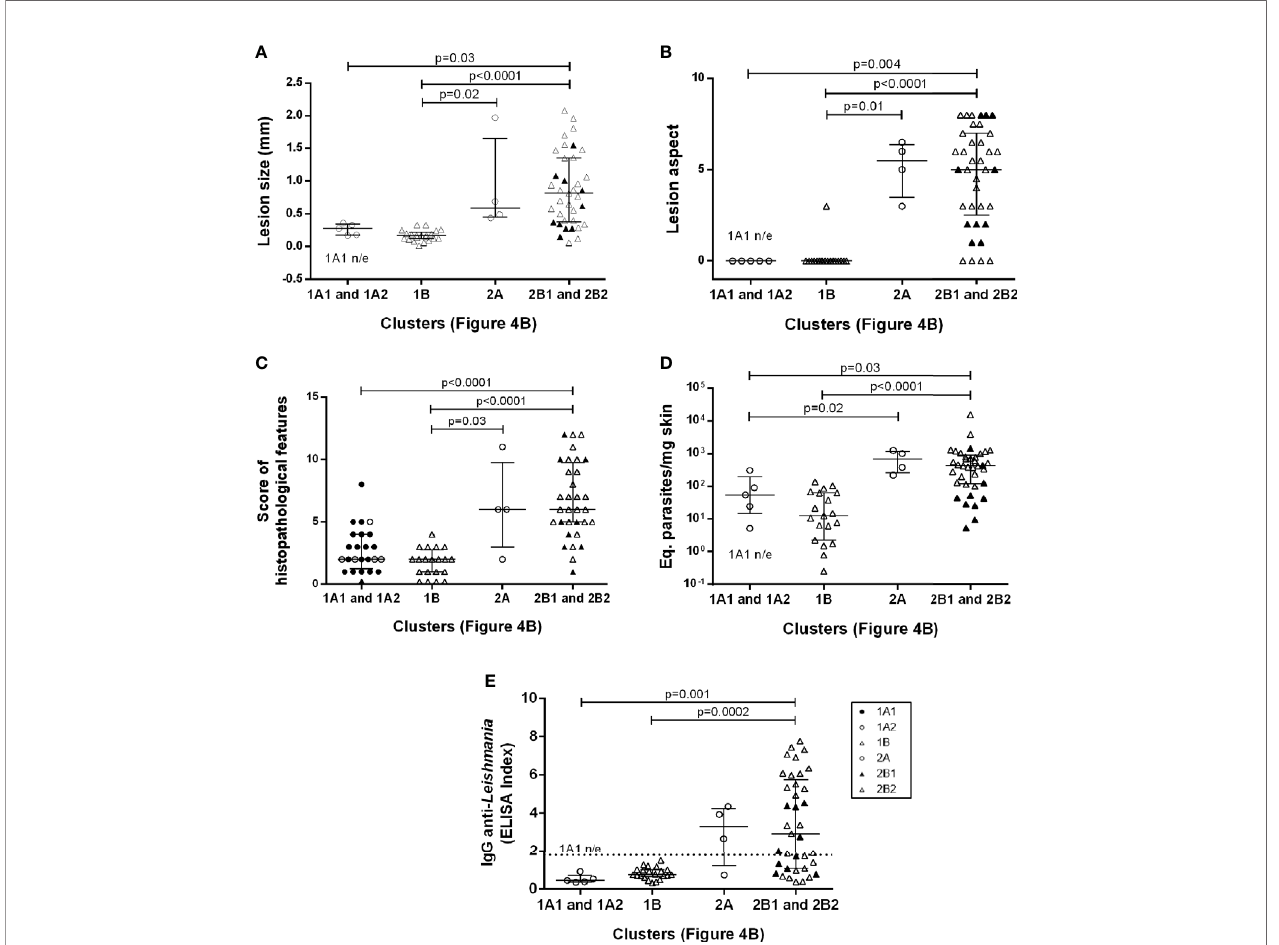
FIGURE 5 | Clinical, (A) Lesion size, (B) Lesion aspect, (C) Score of histopathological features; parasitological (D) Eq. parasites/mg skin; and immunological (E) IgG anti- Leishmania aspects of Leishmania (Viannia) braziliensis hamster infection clustered according to skin cytokine gene expression signatures. The hierarchy average linkage clustering method with Euclidean distance measurement was used (Wishart Research Group at the University of Alberta) based on heat map analysis, as shown in Figure 4B (clusters: 1A1, 1A2, 1B, 2A, 2B1, and 2B2); Biomarker gene expression ( tnf, tgf b , ifn g , il10, il6, il4, arg, inos ); Each symbol represents one animal; The lines in each scatter group represent the median and interquartile range; the dotted line indicates the cut off value for IgG quantitation; ▲ represent the 2B1 subcluster and ● represent the 1A1 subcluster. p – statistical signi fi